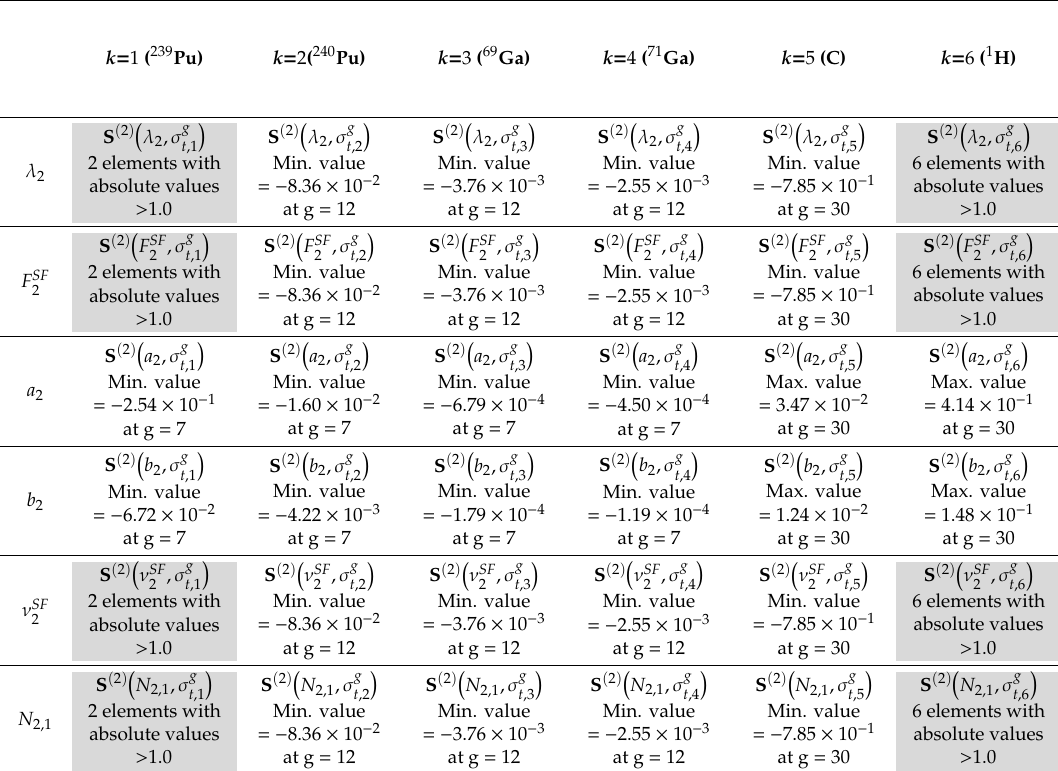
Table 7. Summary presentation of the matrix S ( 2 ) 1, ... ,30, for 2nd-order relative sensitivities of the leakage response with respect to the source parameters of isotope 240 Pu and total cross sections for all